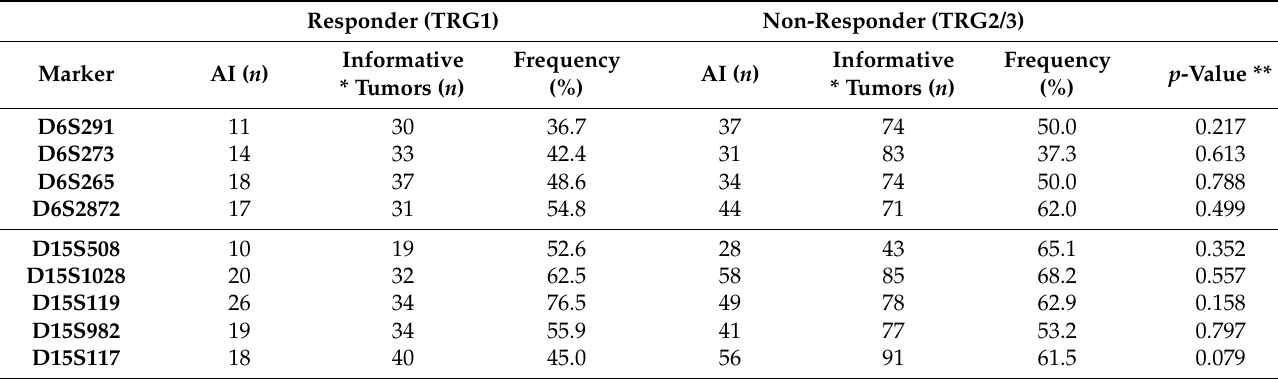
Table 3. Association of AI with response to neoadjuvant